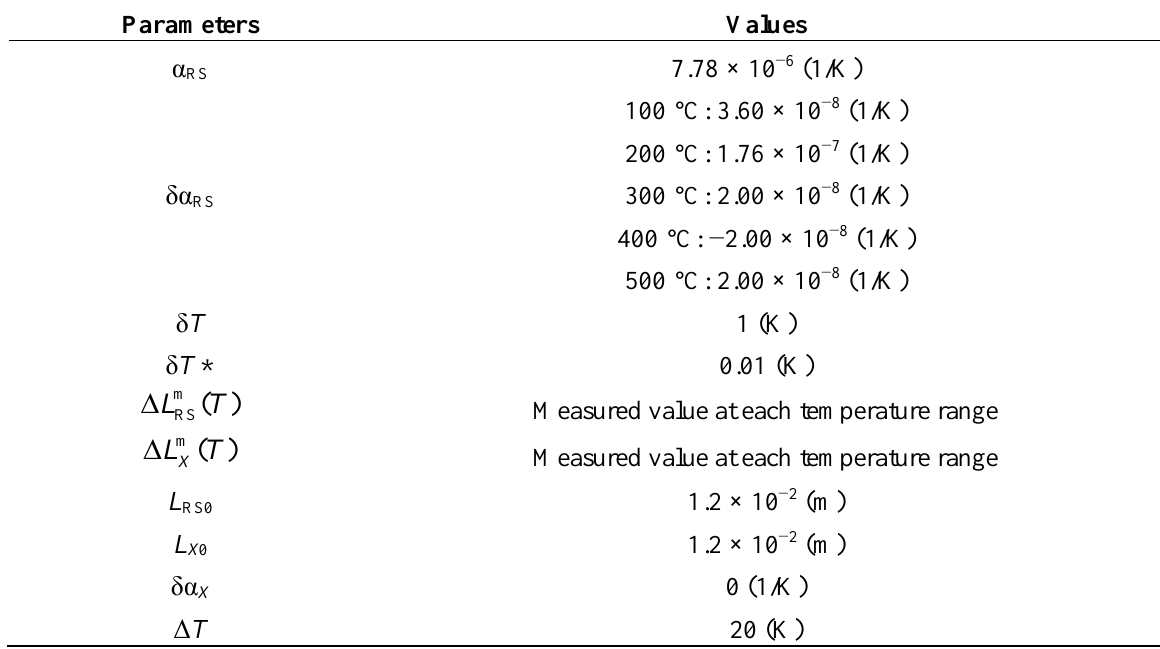
Table 5. Input values for the calculation of